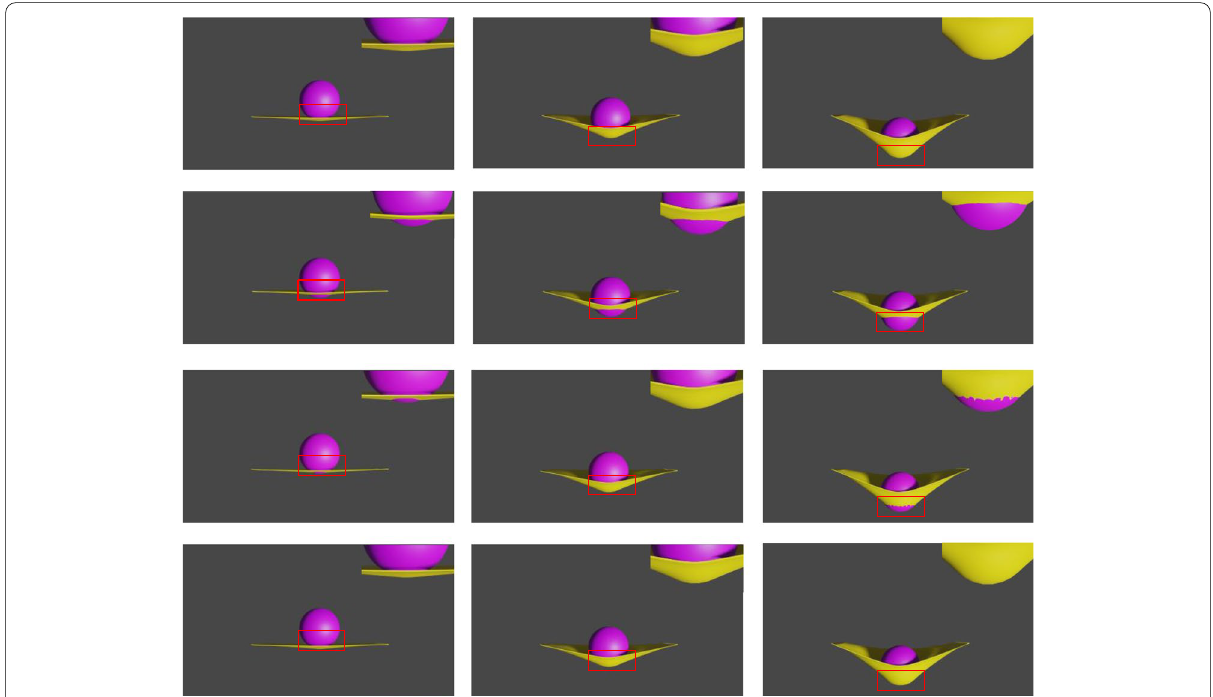
Fig. 6 Comparison. The top row is the ground truth, the second row is the subphysics simulation result, the third row is the baseline simulation result, and the bottom row is the proposed method’s simulation